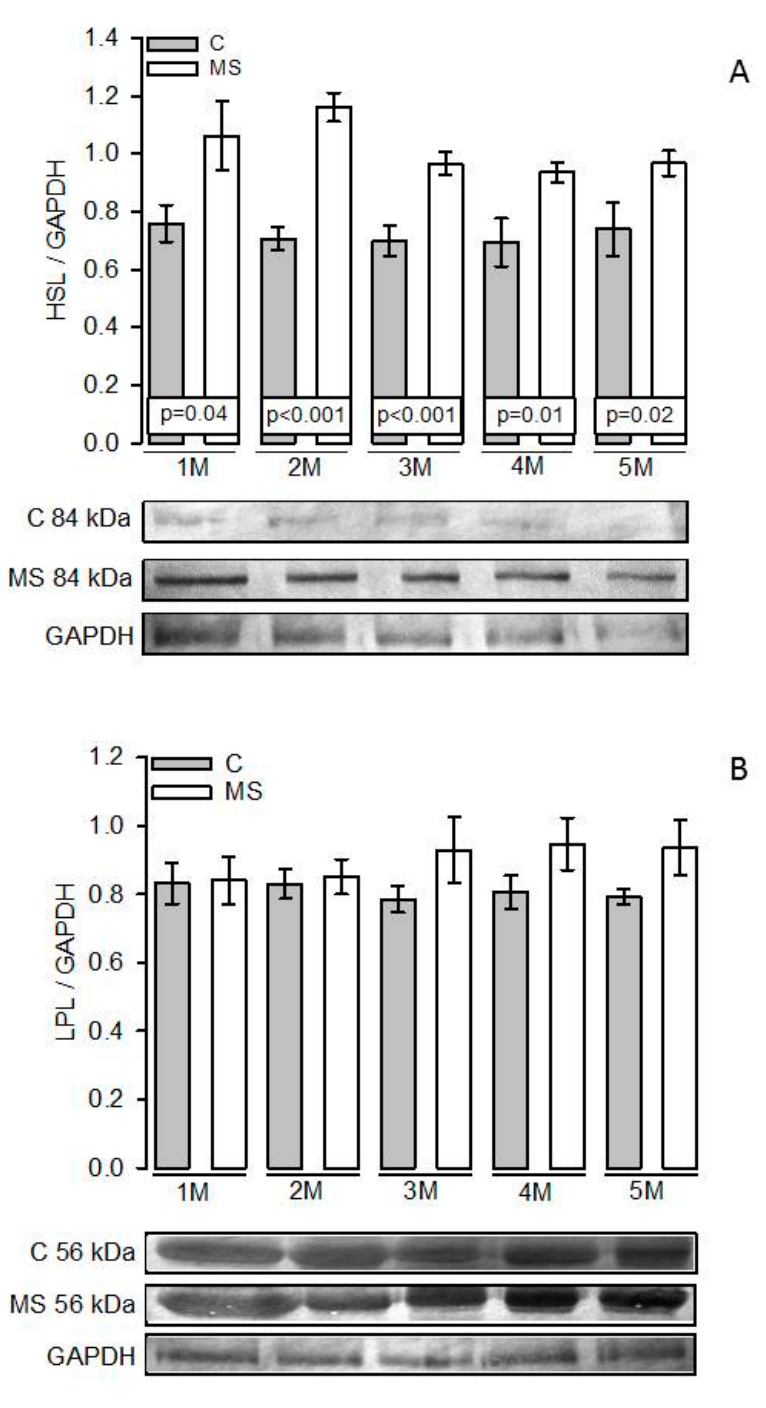
Figure 5. Representative histograms of HSL / GAPDH expression ( A ) and LPL / GAPDH expression ( B ). Values are the mean ± SEM, n = 7 rats per experimental group. Abbreviations: C = Control; MS = Metabolic syndrome; LPL = Lipoprotein lipase; M = Month; HSL = Hormone sensitive lipase.